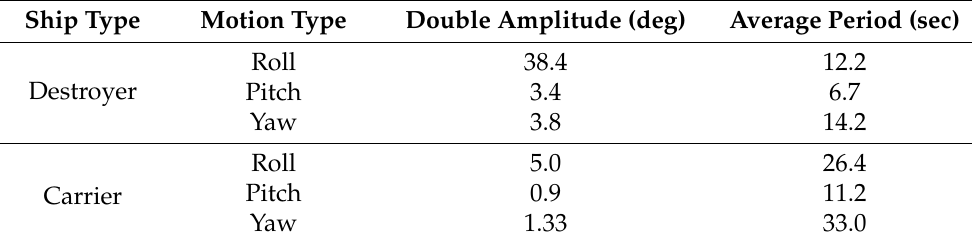
Table 3. Computed worst-case ship motion parameters for two ship types in sea-state